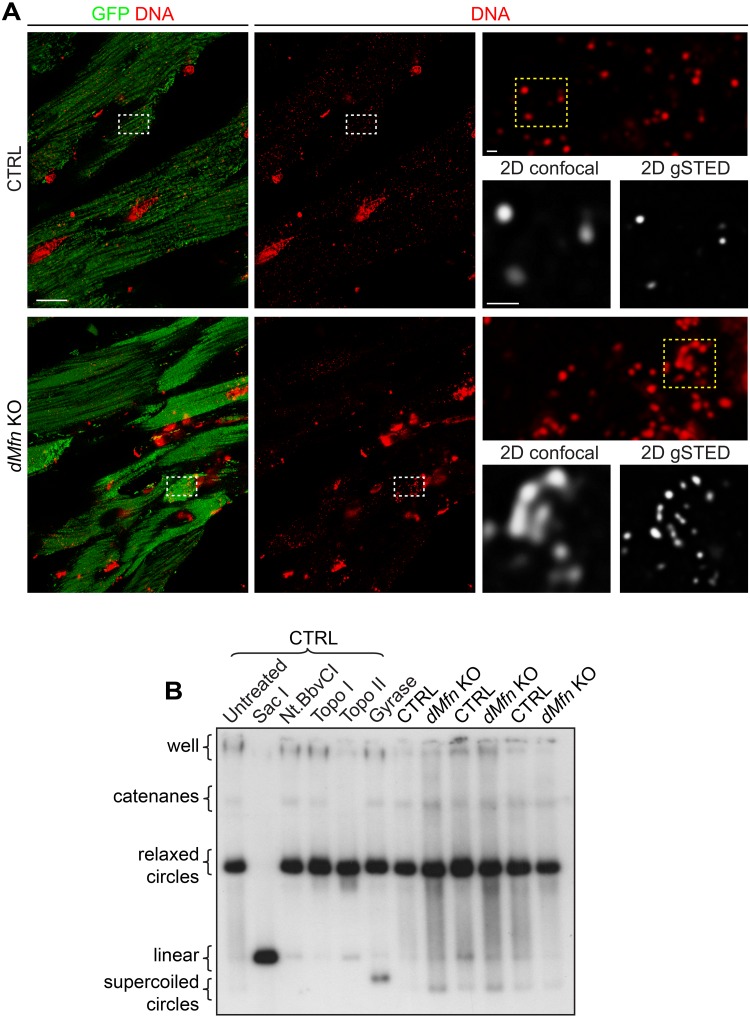
Loss of outer membrane fusion does not affect mtDNA topology.(A) Representative deconvoluted confocal and STED images of mtDNA from heart sections of control and dMfn KO animals at 4 weeks of age. Tissue samples were stained with anti-GFP and anti-DNA antibodies. Left panels show maximal projection of heart sections for mitochondria (GFP), nuclear and mitochondrial DNA (red). White dashed boxes specify areas of magnification shown in top right panel. Bottom right panels show 2D (single stack) images of mitochondrial nucleoids obtained by dual confocal and gated STED (gSTED) microscopy corresponding to the yellow dashed boxed. Scale bars represent 10 μm for overview image, and 500 nm in both zoom-in panels. Staining patterns were determined in three independent animals per genotype. (B) Topology of mtDNA obtained by using total DNA from heart tissue of control (n = 3) and dMfn KO (n = 3) mice at 3 weeks of age. The high molecular weight portion of the gel is shown. Control mtDNA was either untreated or treated with SacI, NtBbvCI, topoisomerase I (Topo I), topoisomerase II (Topo II), or DNA gyrase enzymes. mtDNA was probed with pAM1 (mouse mtDNA).